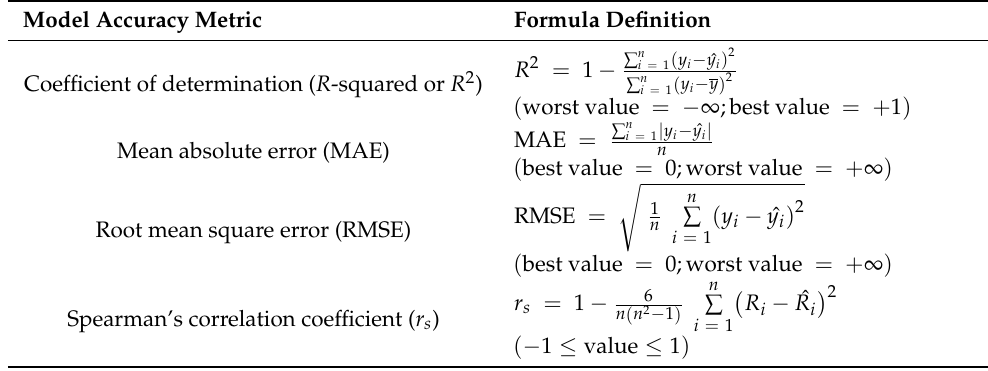
Table 1. Performance evaluation measure of the regression model. Model Accuracy